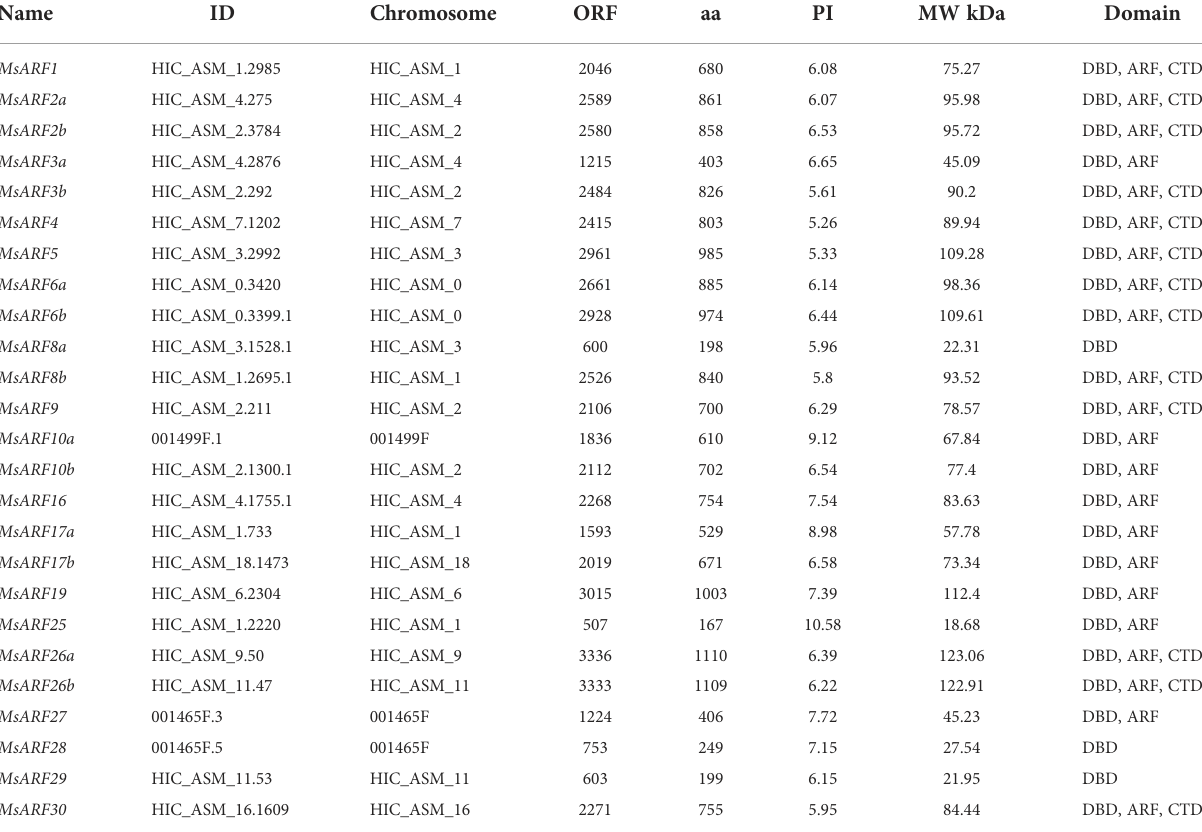
TABLE 2 Summary of MsARF genes encoding ARF proteins in M. sieboldii